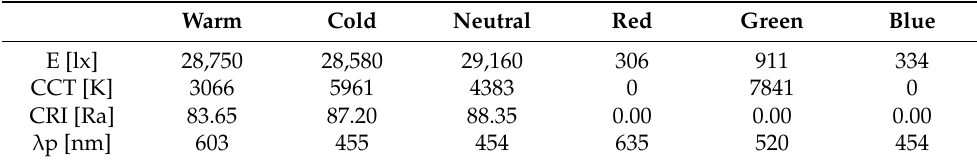
Table 3. Photometric values of the LED light